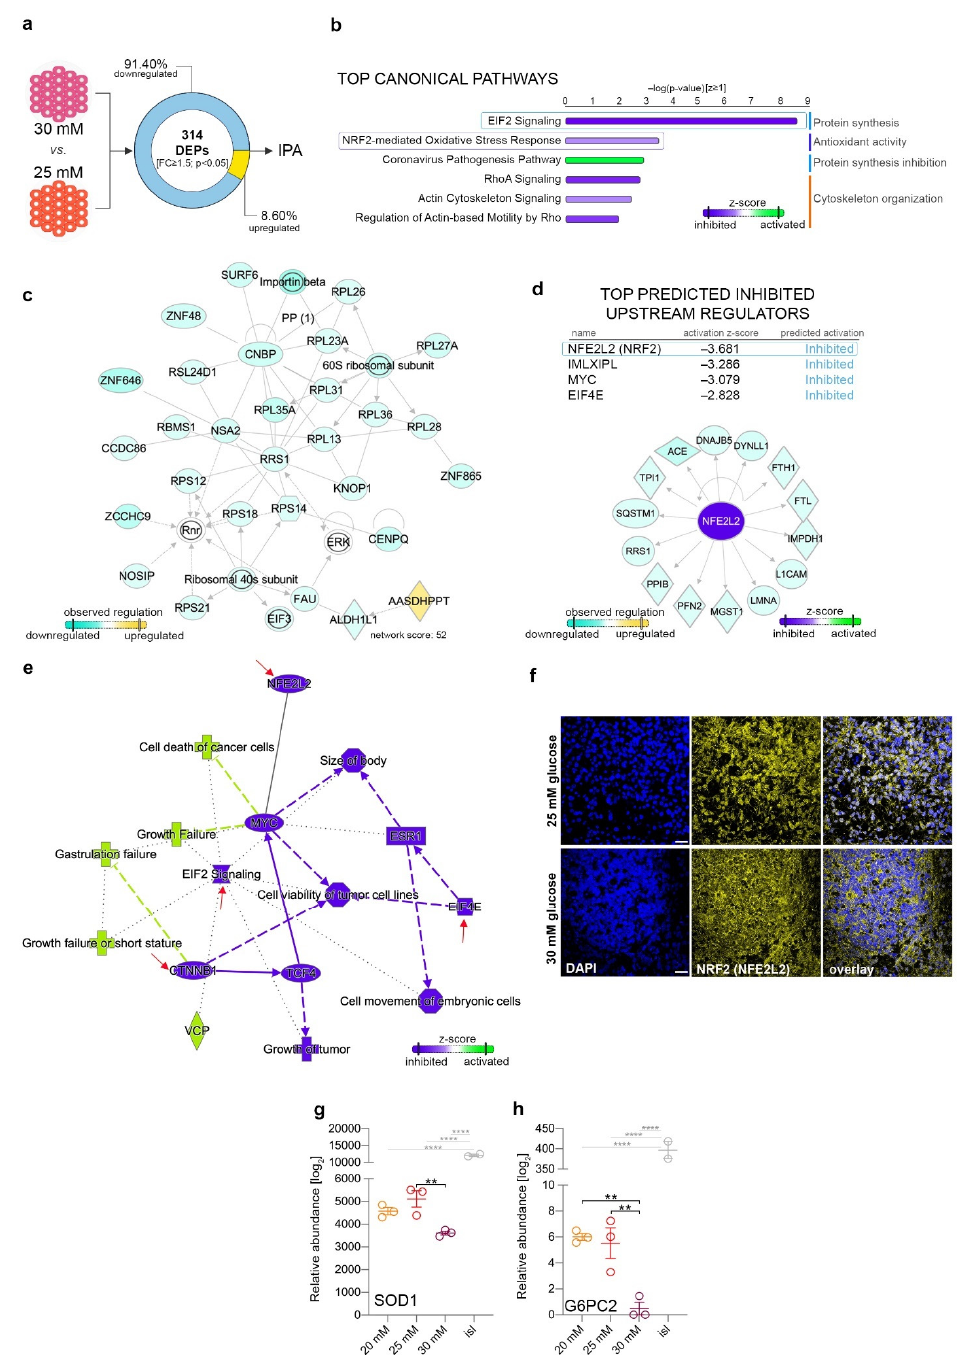
Figure 4. Direct comparison analysis between the proteome landscape of 30 and 25 mM glucose conditions. ( a ) Analysis workflow depicting the comparison employed. ( b ) Top canonical pathways with predicted regulation characterizing the differentially expressed protein landscape between 30 and 25 mM glucose conditions. ( c ) Selected top 2 organic networks displaying the observed downregulation of proteins involved in protein synthesis. ( d ) Top predicted activated upstream transcription regulators and the NFE2L2 (NRF2) target molecules observed regulated in the analyzed DEPs dataset. ( e ) IPA-generated global integration of all pathway analysis levels characterizing the differentially expressed protein landscape between 30 and 25 mM glucose conditions. ( f ) Confocal imaging of representative NRF2 + cells (yellow) in 25- and 30-mM - treated samples (Scale bar: 25 µ m; blue–DAPI). ( g ) Relative abundance levels of superoxide dismutase 1 (SOD1) and ( h ) G6PC2 (Glucose-6-Phosphatase Catalytic Subunit 2) proteins (one-way ANOVA with Tukey’s multiple comparisons test, ** p < 0.01, **** p < 0.0001). Graphs are shown as mean ±